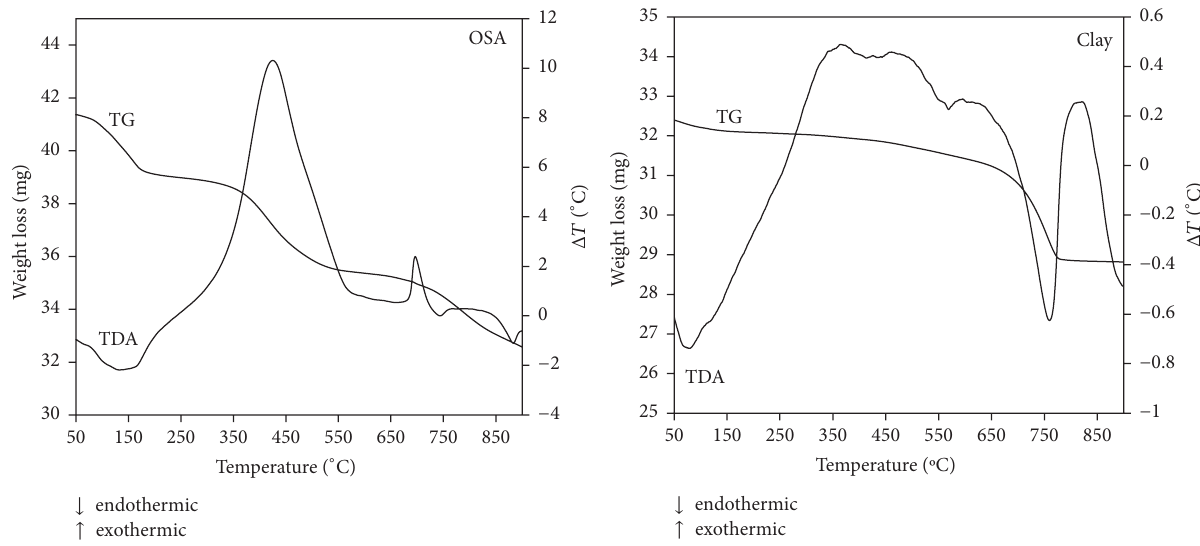
Figure 4: TG-DTA analysis of (a) olive stone ash and (b) raw clay.